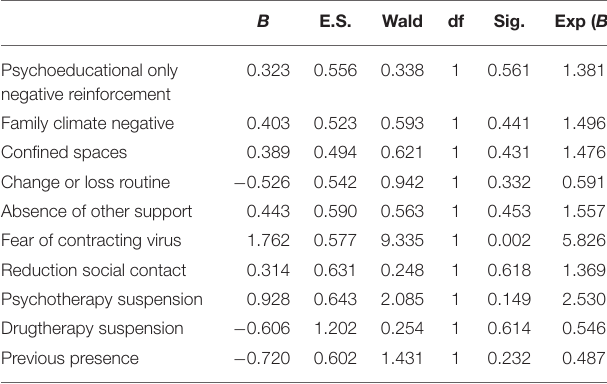
TABLE 15 | Regression between negative factors and onset of new symptoms (section III-IV). B E.S. Wald df Sig. Exp ( B